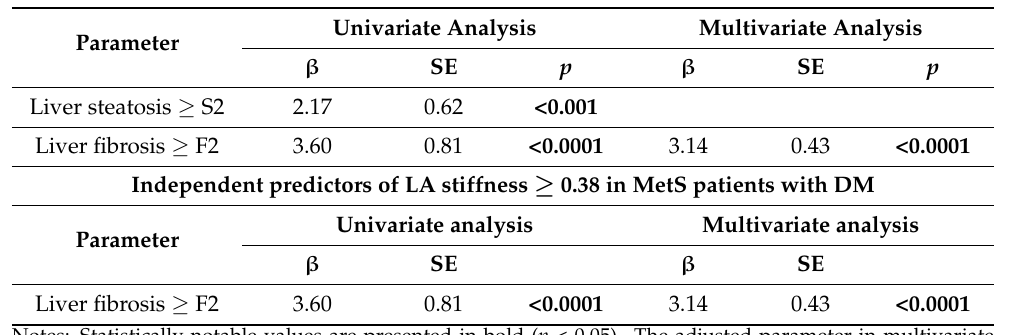
Table 4. Independent predictors of LV systolic dysfunction in MetS patients with